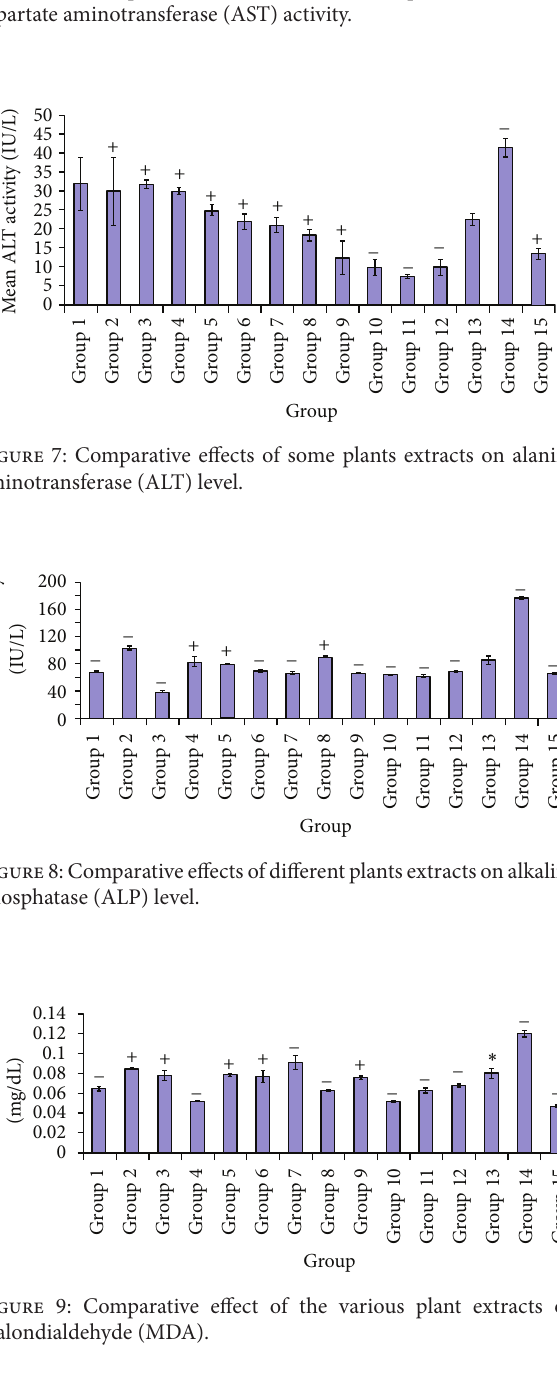
−− Figure 6: Comparative effects of the some plants extracts on aspartate aminotransferase (AST) activity.